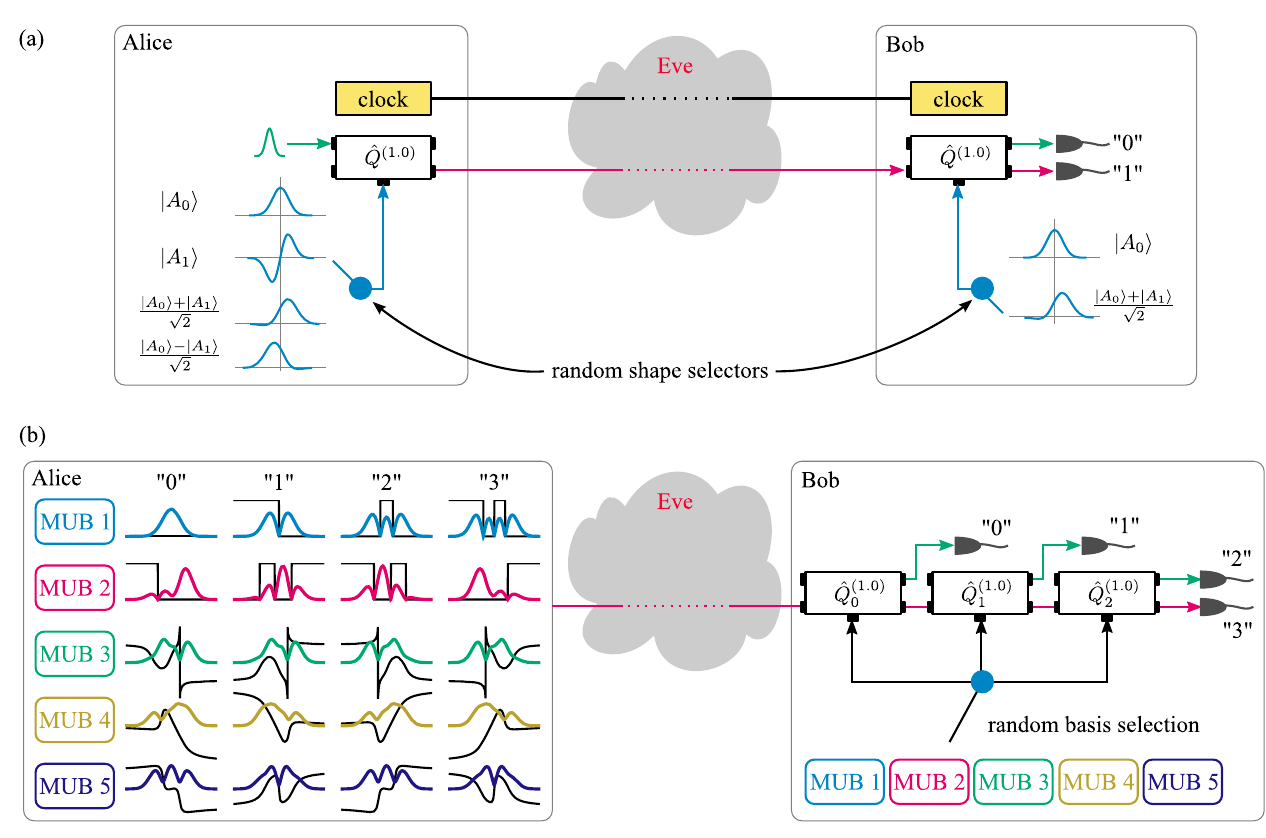
FIG. 11. (a) Implementation of the BB84 QKD protocol with TMs. Alice randomly prepares one of four possible basis states and sends it to Bob, who randomly measures in one of two MUBs. The two outputs of Bob ’ s QPG correspond to 0 and 1. (b) Generalized BB84 in a four-dimensional encoding scheme. Alice randomly prepares one of the 20 possible basis states. Bob chooses randomly one of the five MUBs to measure. Note that in this case he requires three QPGs to fully resolve the four possible basis states of each